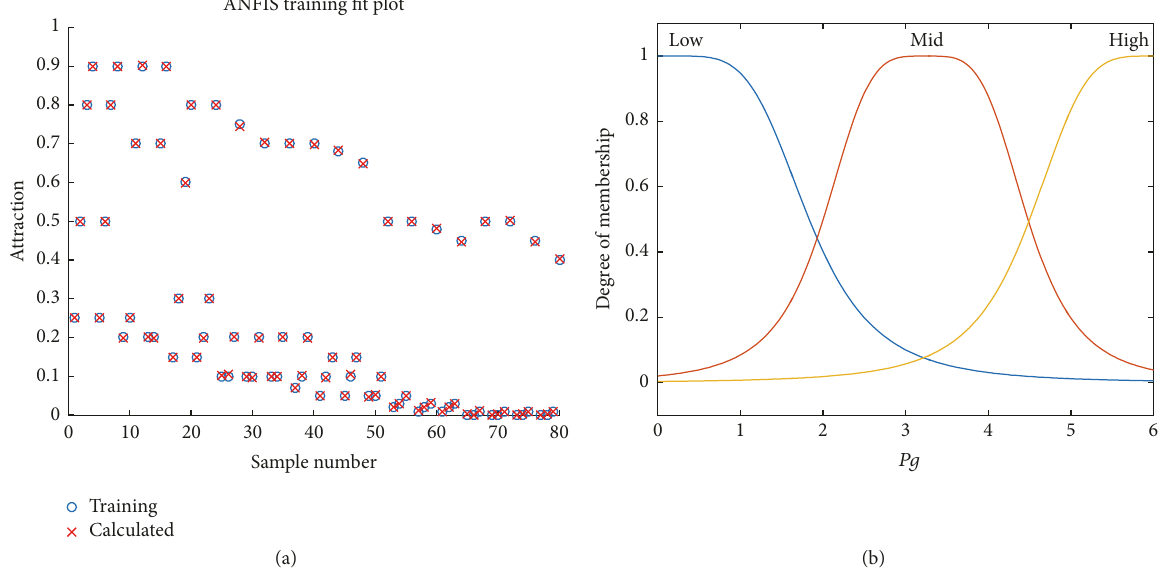
Figure 8: ANFIS training (a) and 𝑃𝑔 membership functions (b).